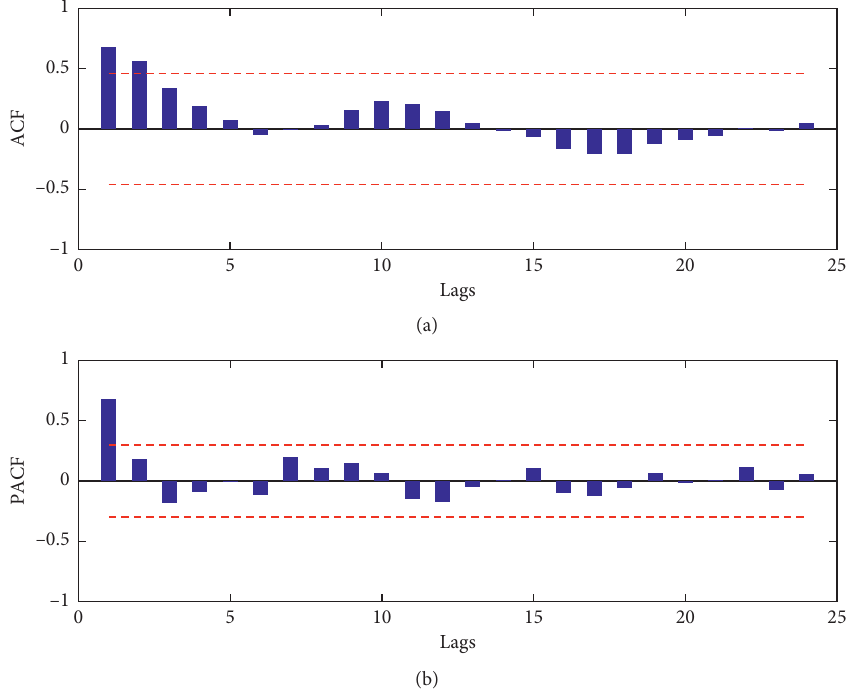
Figure 4: The ACF and PACF graphs of TB incidence. (a) ACF with 2stds Bounds (i.e., approximate 95% confidence interval). (b) PACF with 2stds Bounds (i.e., approximate 95% confidence interval).